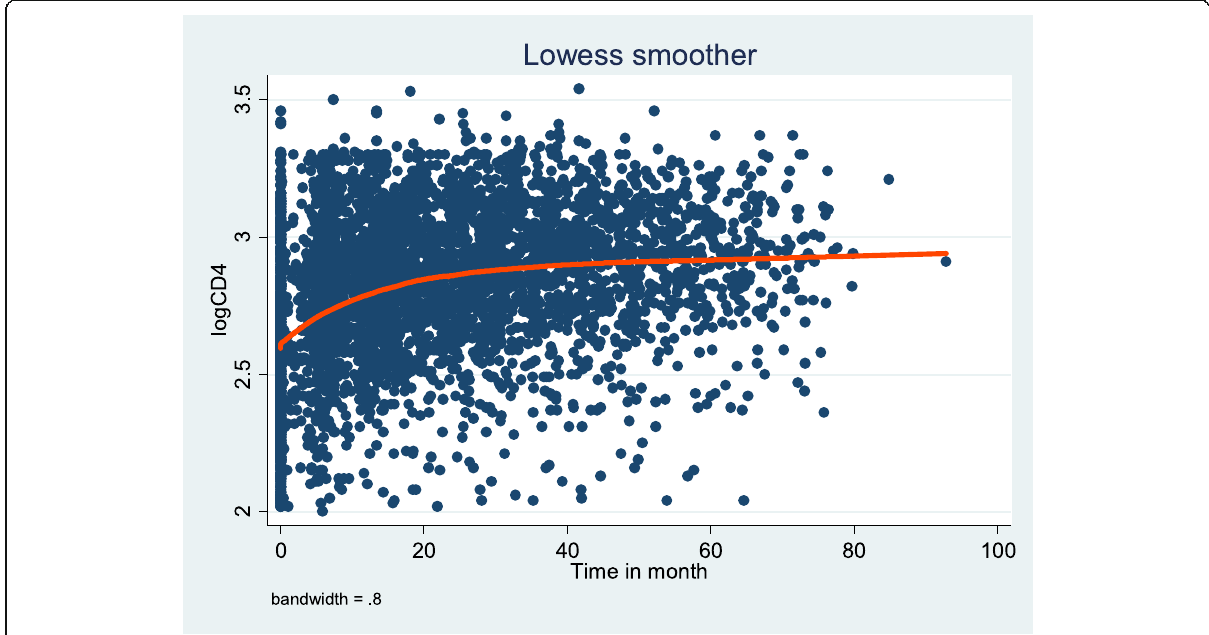
Fig. 2 Smoothing mean profile plots for the logCD4 count after the initiation of ART among children in Ethiopia from 2010 to